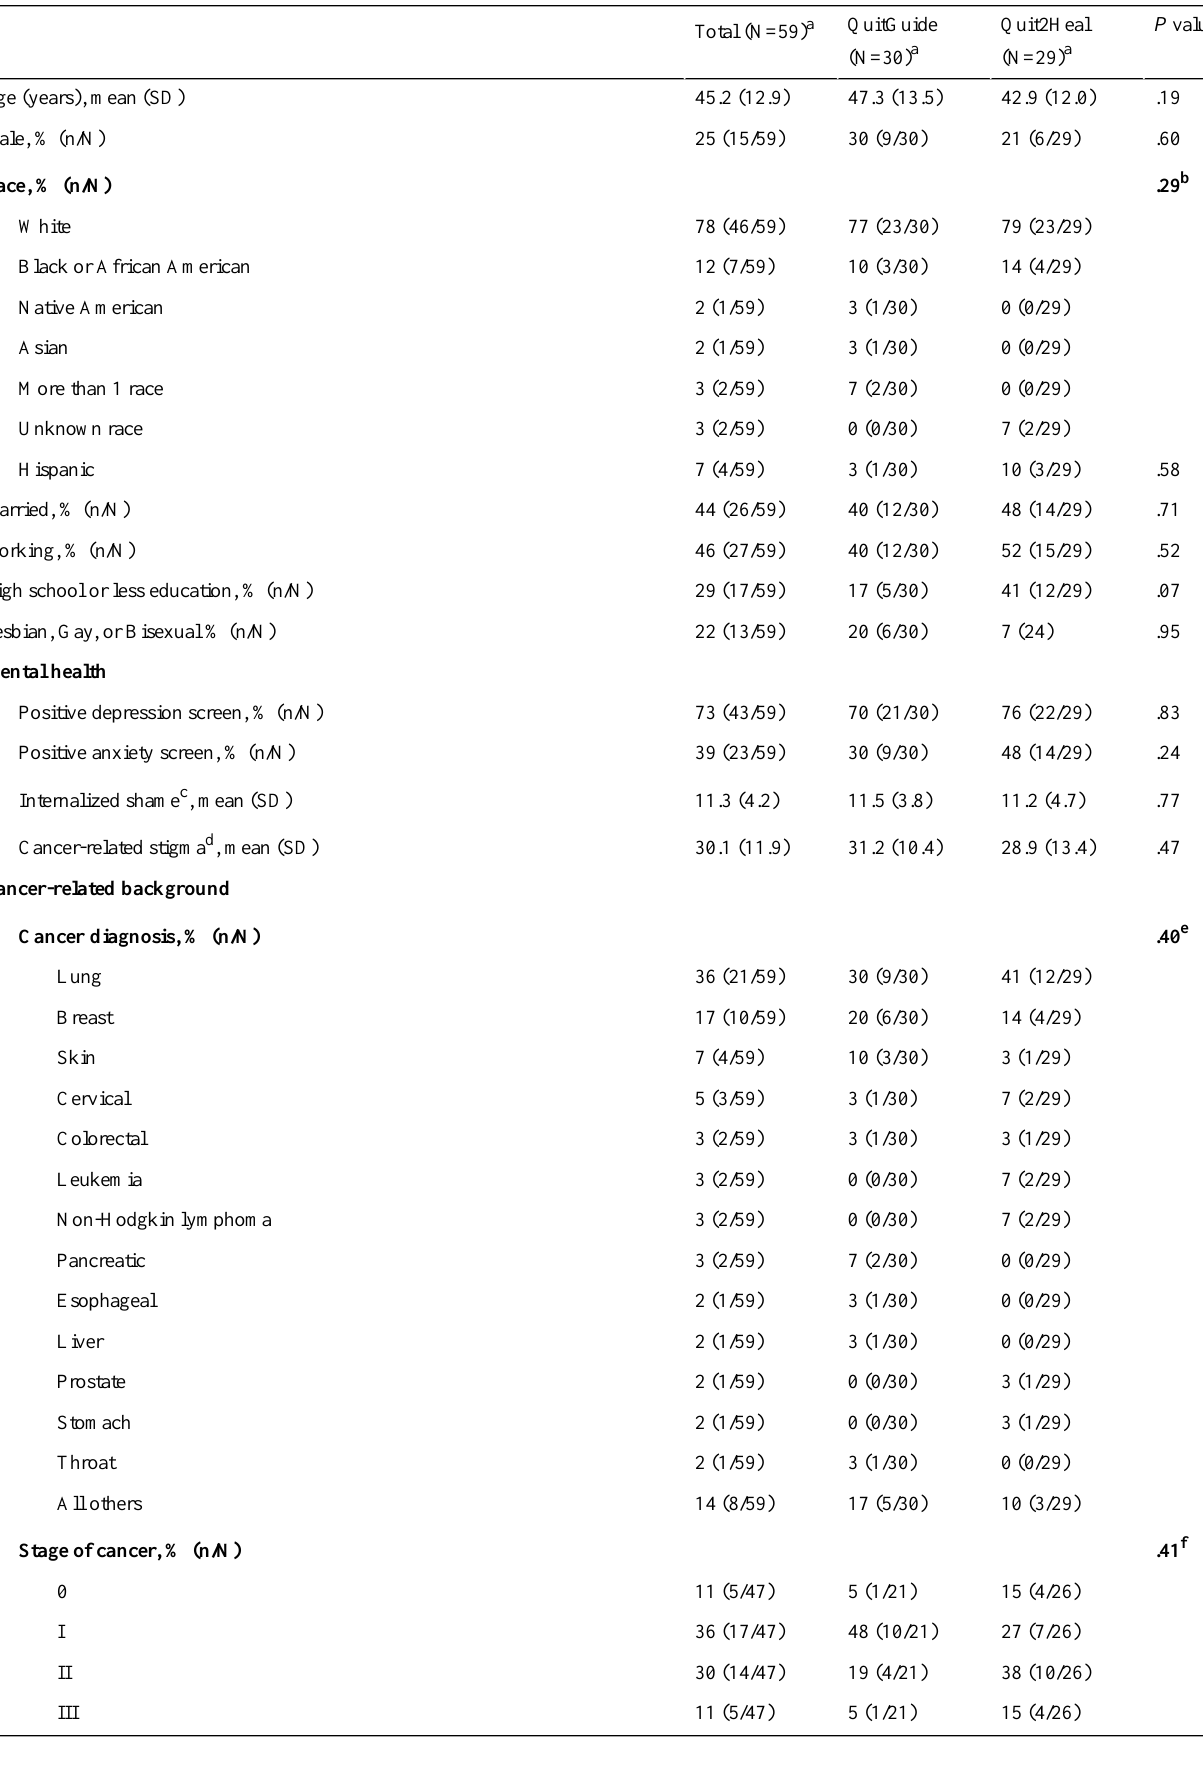
Table 1. Baseline characteristics of Quit2Heal study